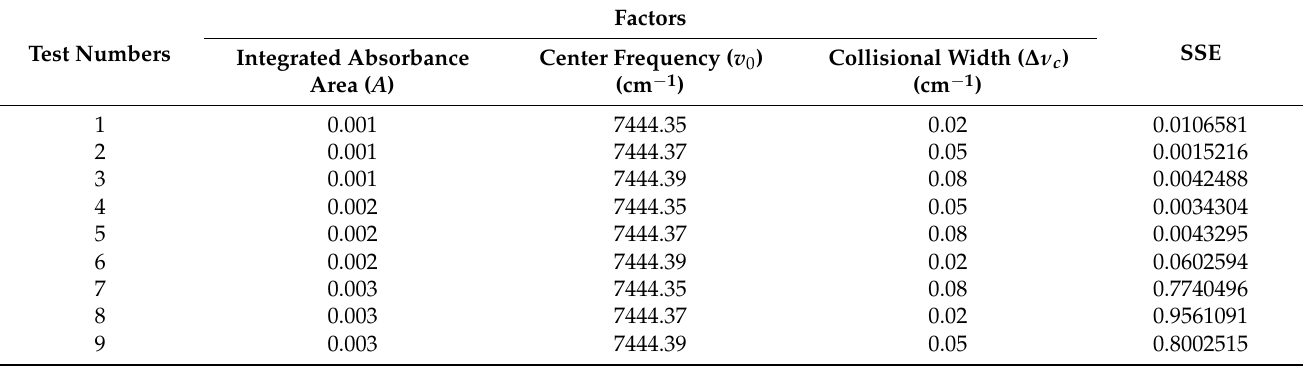
Table 2. Orthogonal Array L 9 (3 4 ) and the SSE.